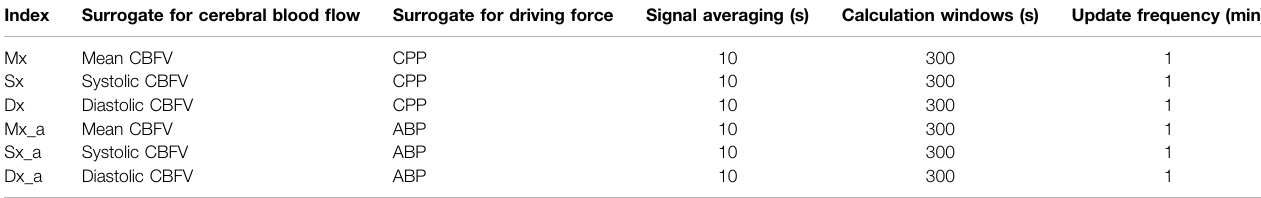
TABLE 1 | Various transcranial Doppler based Indices of cerebrovascular reactivity with their component signals and derivation.